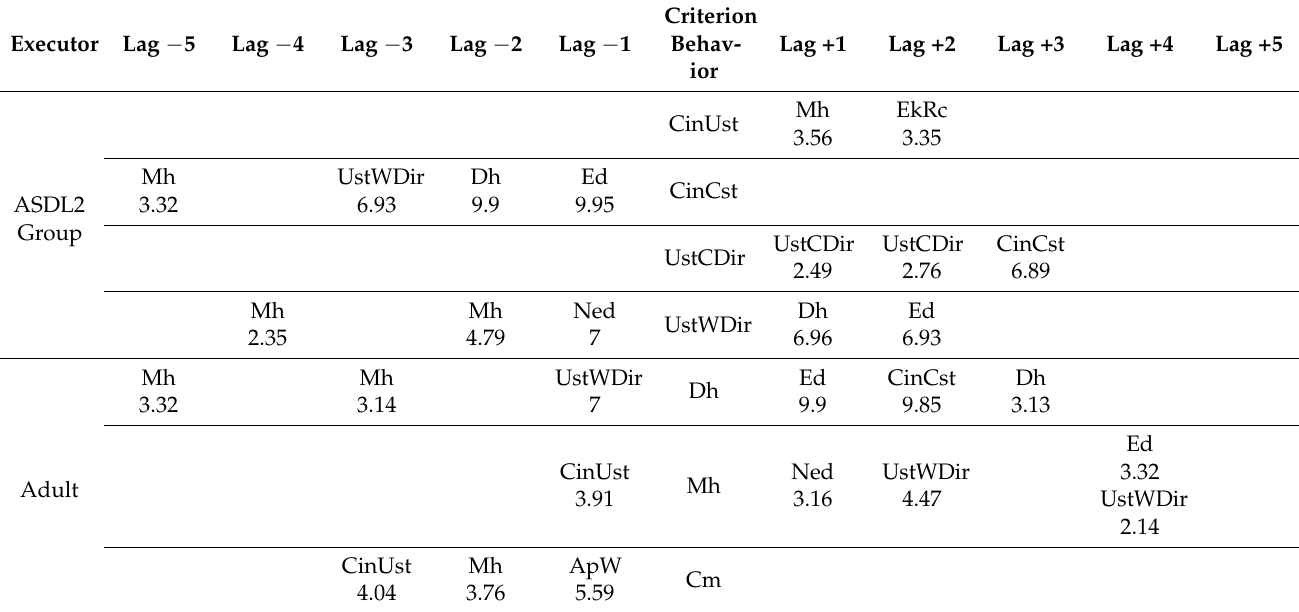
Table 9. Behavioral patterns obtained in the ASDL2 Group one month after the intervention finished (post-intervention task). Central column = It contains the criteria behaviors. Remaining cells = They contain the conditional behaviors. Numbers = Significant adjusted residuals values. Green codes = The most relevant behaviors indicating children progress in interference control. Red codes = The most relevant wrong interference control behaviors of the children. Blue codes = The most relevant adult scaffolding